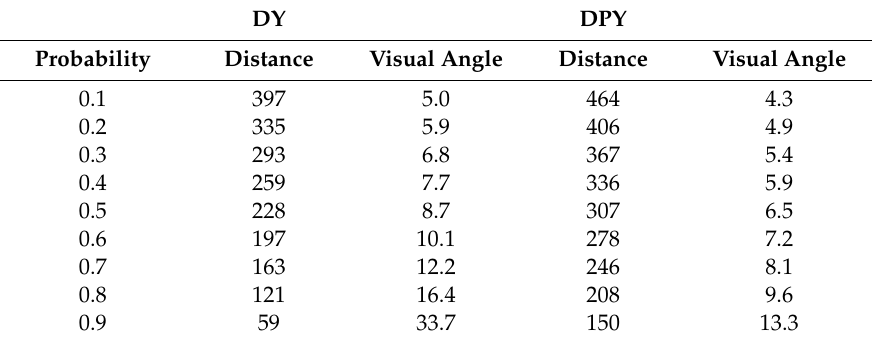
Table 2. Estimated distance (m) and visual angle (10 − 2 degree) for the line-of-sight (LOS). DY DPY Probability Distance Visual Angle Distance Visual Angle 0.1 397